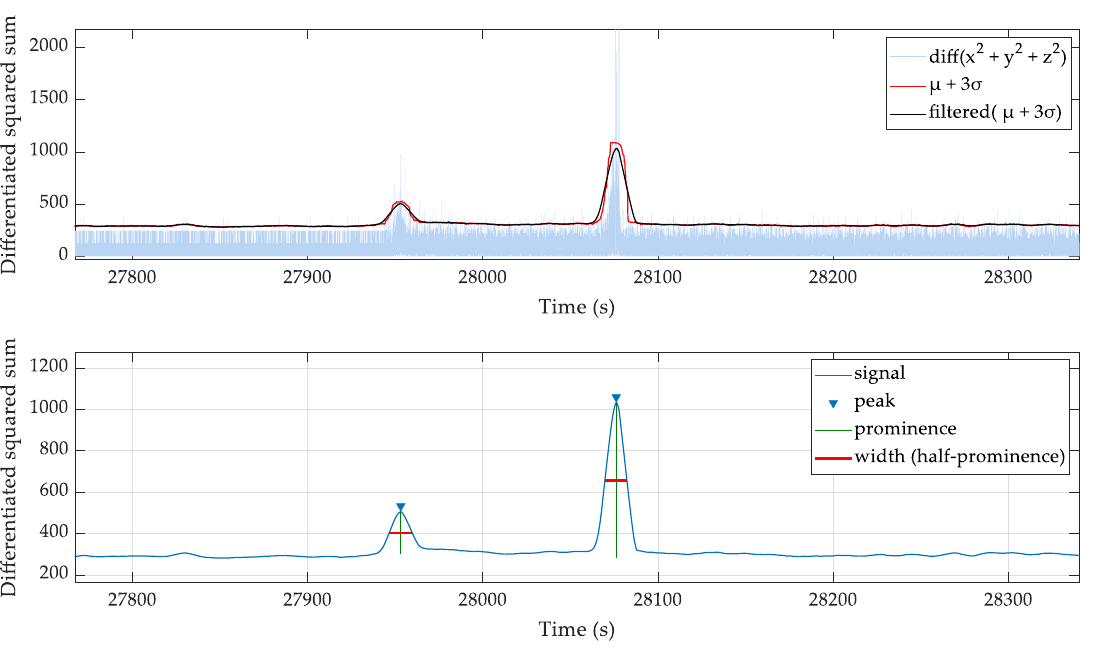
Figure 3. The squared sum of accelerometer channels and the usage of filtered moving standard deviation to identify regions of high activity blocks.